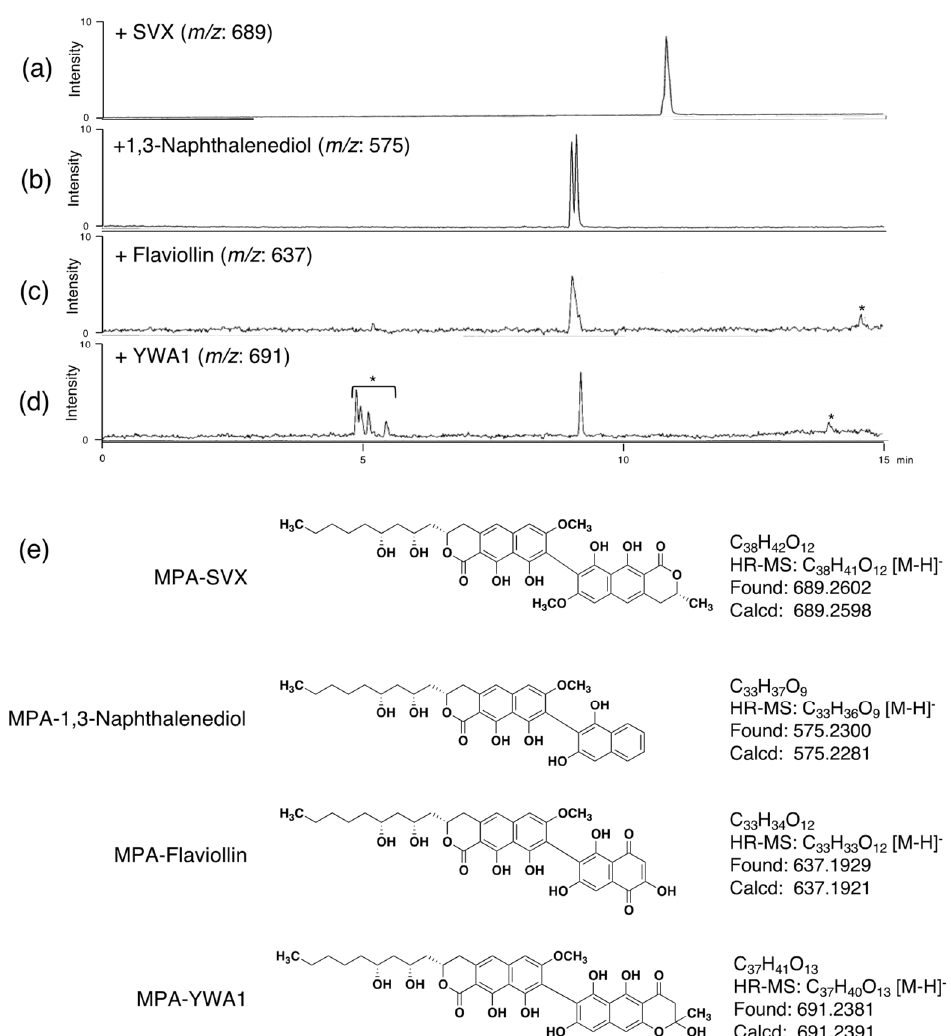
Figure 3. LC ‐ MS analysis of the heterodimers of MPA formed with cyclic compounds. ( a – d ) Ex ‐ tracted ion chromatogram of the MCE reaction of MPA with the indicated compound. ( a ) MPA ‐ SVX ( m / z = 689), ( b ) MPA ‐ 1,3 ‐ naphthalenediol ( m / z = 575), ( c ) MPA ‐ flaviolin ( m / z = 637), and ( d ) MPA ‐ YWA1 ( m / z = 691). LC conditions: Capcell Core C18 (i.d. 2.1 × 50 mm, maintained at 40 °C); mobile phase, 25 min linear gradient of 30 to 95% CH 3 CN ‐ 0.1% HCOOH; flow rate, 0.4 mL ∙ min − 1 . * Back ‐ ground peaks coming from the culture supernatant were observed. ( e ) HR ‐ MS analysis and putative structures of the heterodimers formed with MPA and the cyclic compounds.